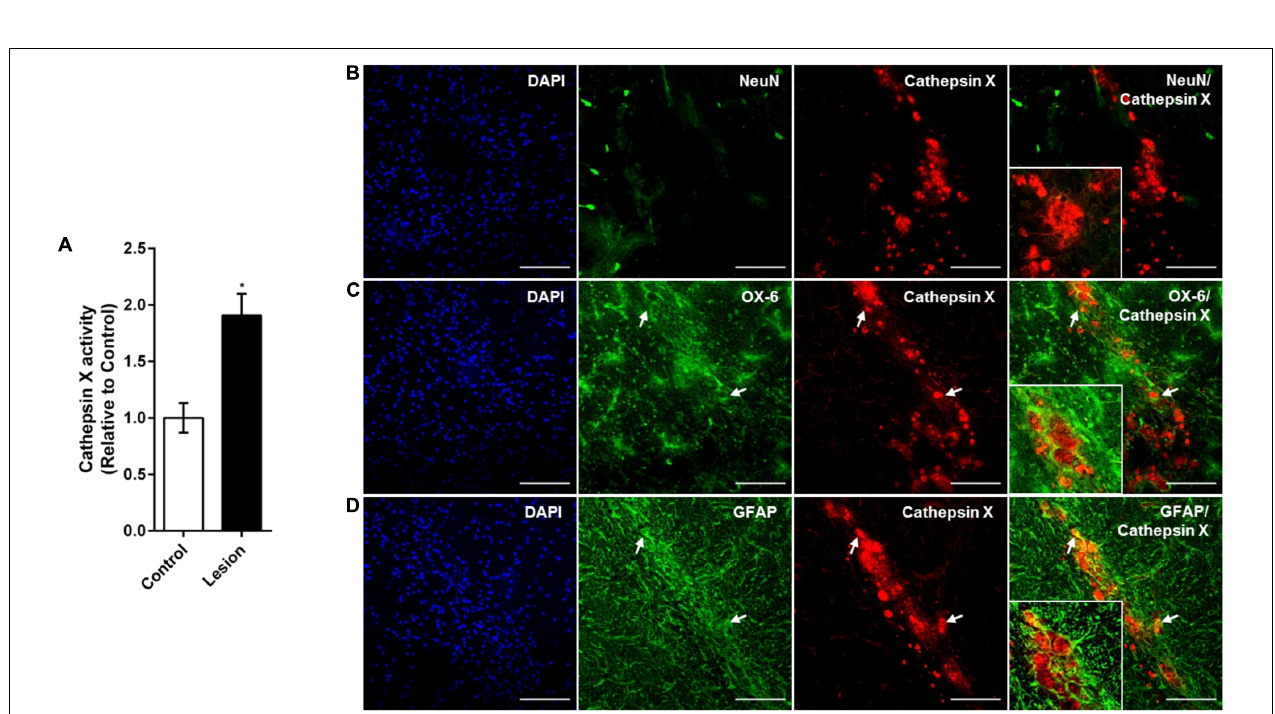
FIGURE 5 | Increased expression of cathepsin X in TH-positive neurons in the SNc after 6-OHDA injection. Representative images of double immunofluorescence staining of TH (green fluorescence) and cathepsin X (red fluorescence) in the SNc at 12 h after the injection of 6-OHDA. Nuclei were counterstained with DAPI (blue fluorescence). In the contralateral SNc (Control), single TH-positive neuronal cells were cathepsin X-positive (A) , whereas cathepsin X was upregulated in the majority of TH-positive cells in the ipsilateral SNc (Lesion) (B) . Some surrounding TH-negative cells in contralateral and ipsilateral SNc were also cathepsin X-positive, as indicated by white arrows. Groups of four animals ( n = 4) were analyzed and four sections of the SNc region of each animal were analyzed. Scale bar = 100 µ m.